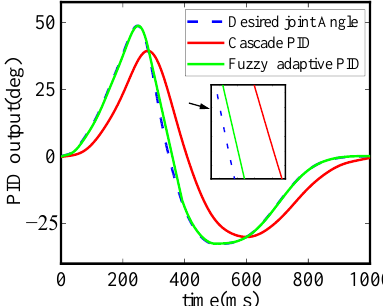
Figure 9. Comparison between the optimized angular displacement input curve and the desired curve.